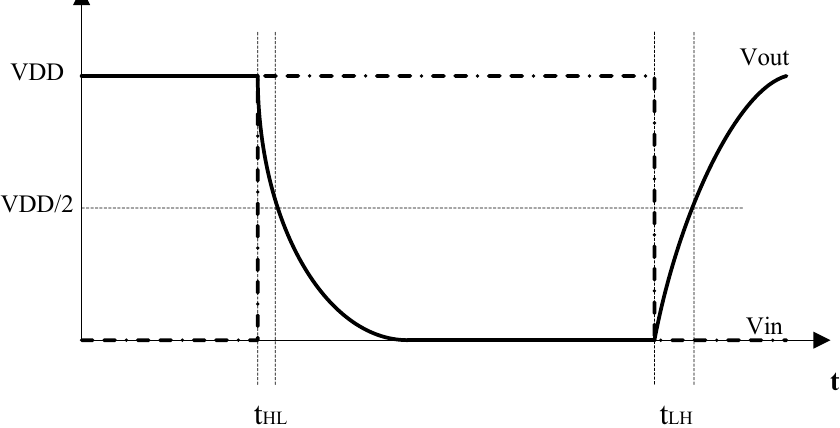
Figure 5. A SET pulse at the input and output of an Inverter and its HL and LH propagation delays. Through an adequate number of SPICE simulations, it is observed that the transient pulse is deformed as it propagates through a logic gate, thus allowing for the modeling of the SET pulse propagation through a logic path. SET pulses of various output capacitance loads and several widths are taken into consideration. It should be emphasized that the applied output capacitance corresponds to the number of fanouts that a gate may have as well as the interconnection parasitics at its output, which means that it is a significant parameter for the delay of the